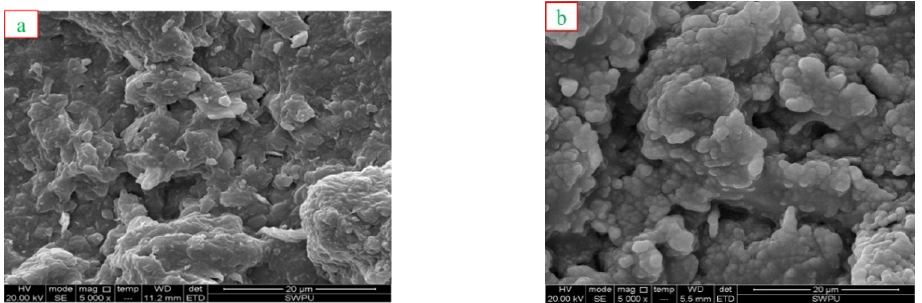
Figure 11. SEM observations of Na-MMT: ( a ) basic mud cake, and ( b ) composite formed after treatment with 2 wt % copolymer SX-1.